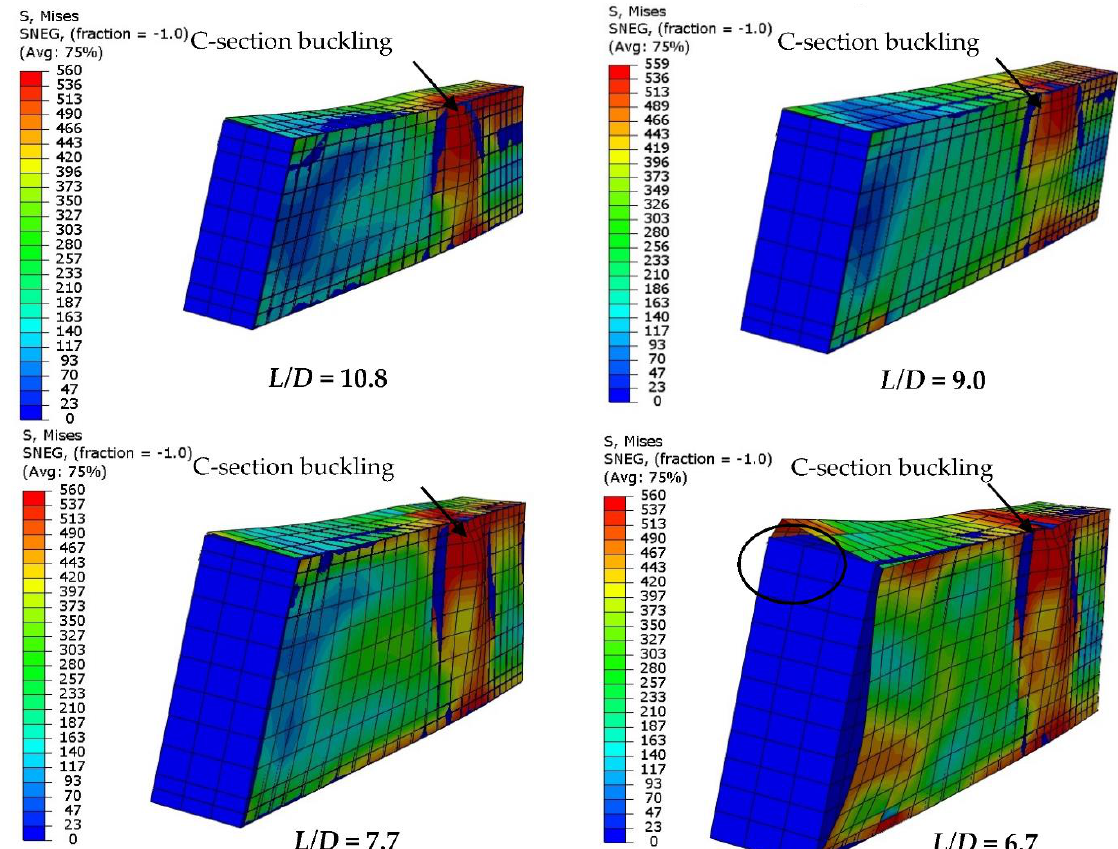
Figure 23. Effects of the L / D ratio on the steel C-section’s buckling behavior.